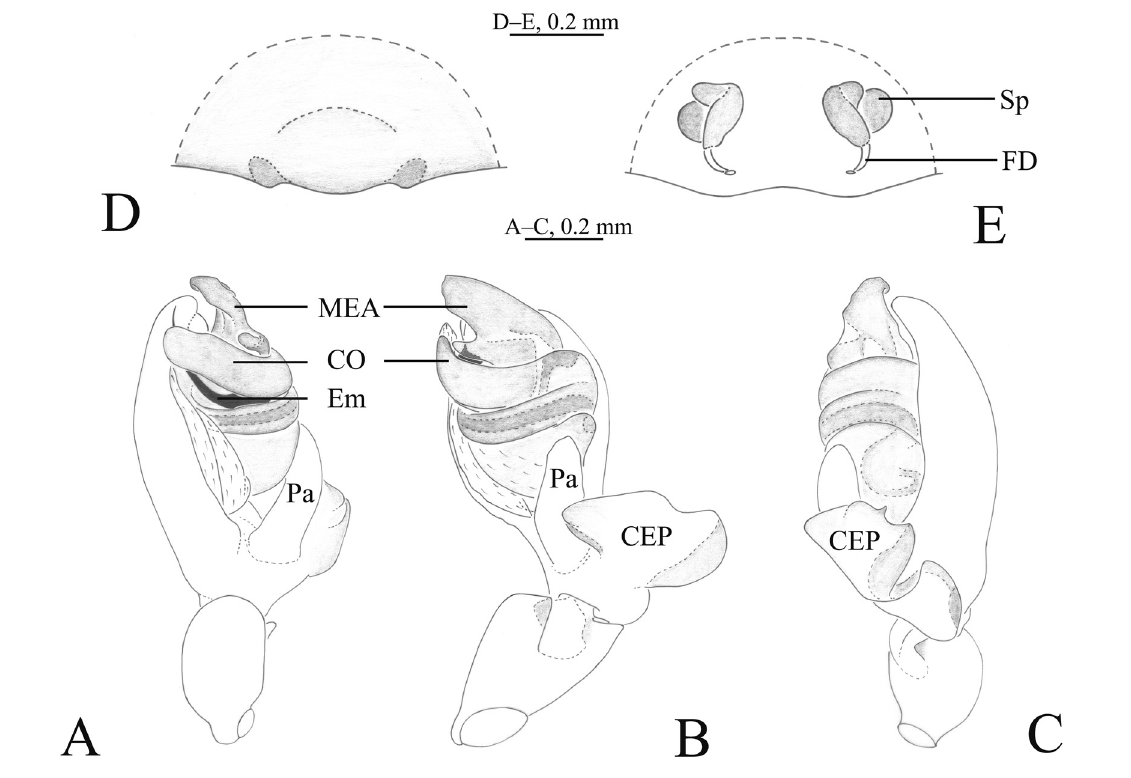
Fig. 2. Meta bowo sp. nov. A–C . ♂, holotype (SWUC-T-TEg-02-01). D–E . ♀, paratype (SWUC-T- TEg-02-06). A . Left palp, prolateral view. B . Same, ventral view. C . Same, retrolateral view. D . Epigyne, ventral view. E . Vulva, dorsal